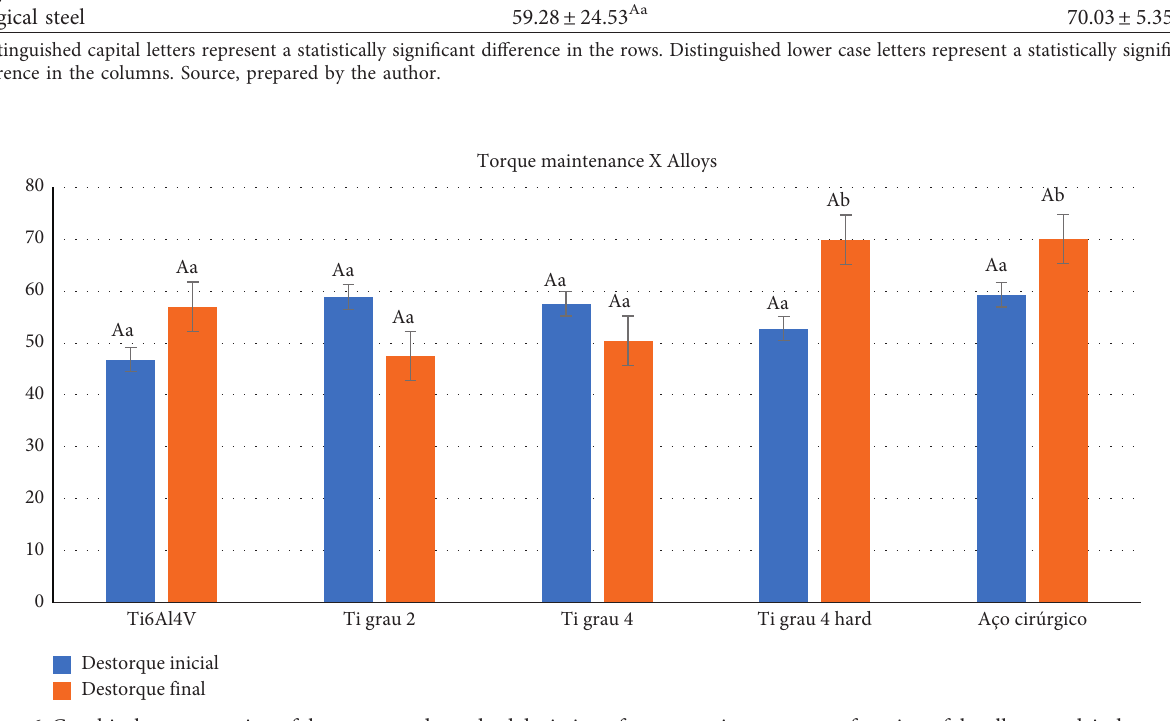
Figure 6: Graphical representation of the means and standard deviation of torque maintenance as a function of the alloys used, independent of the period.